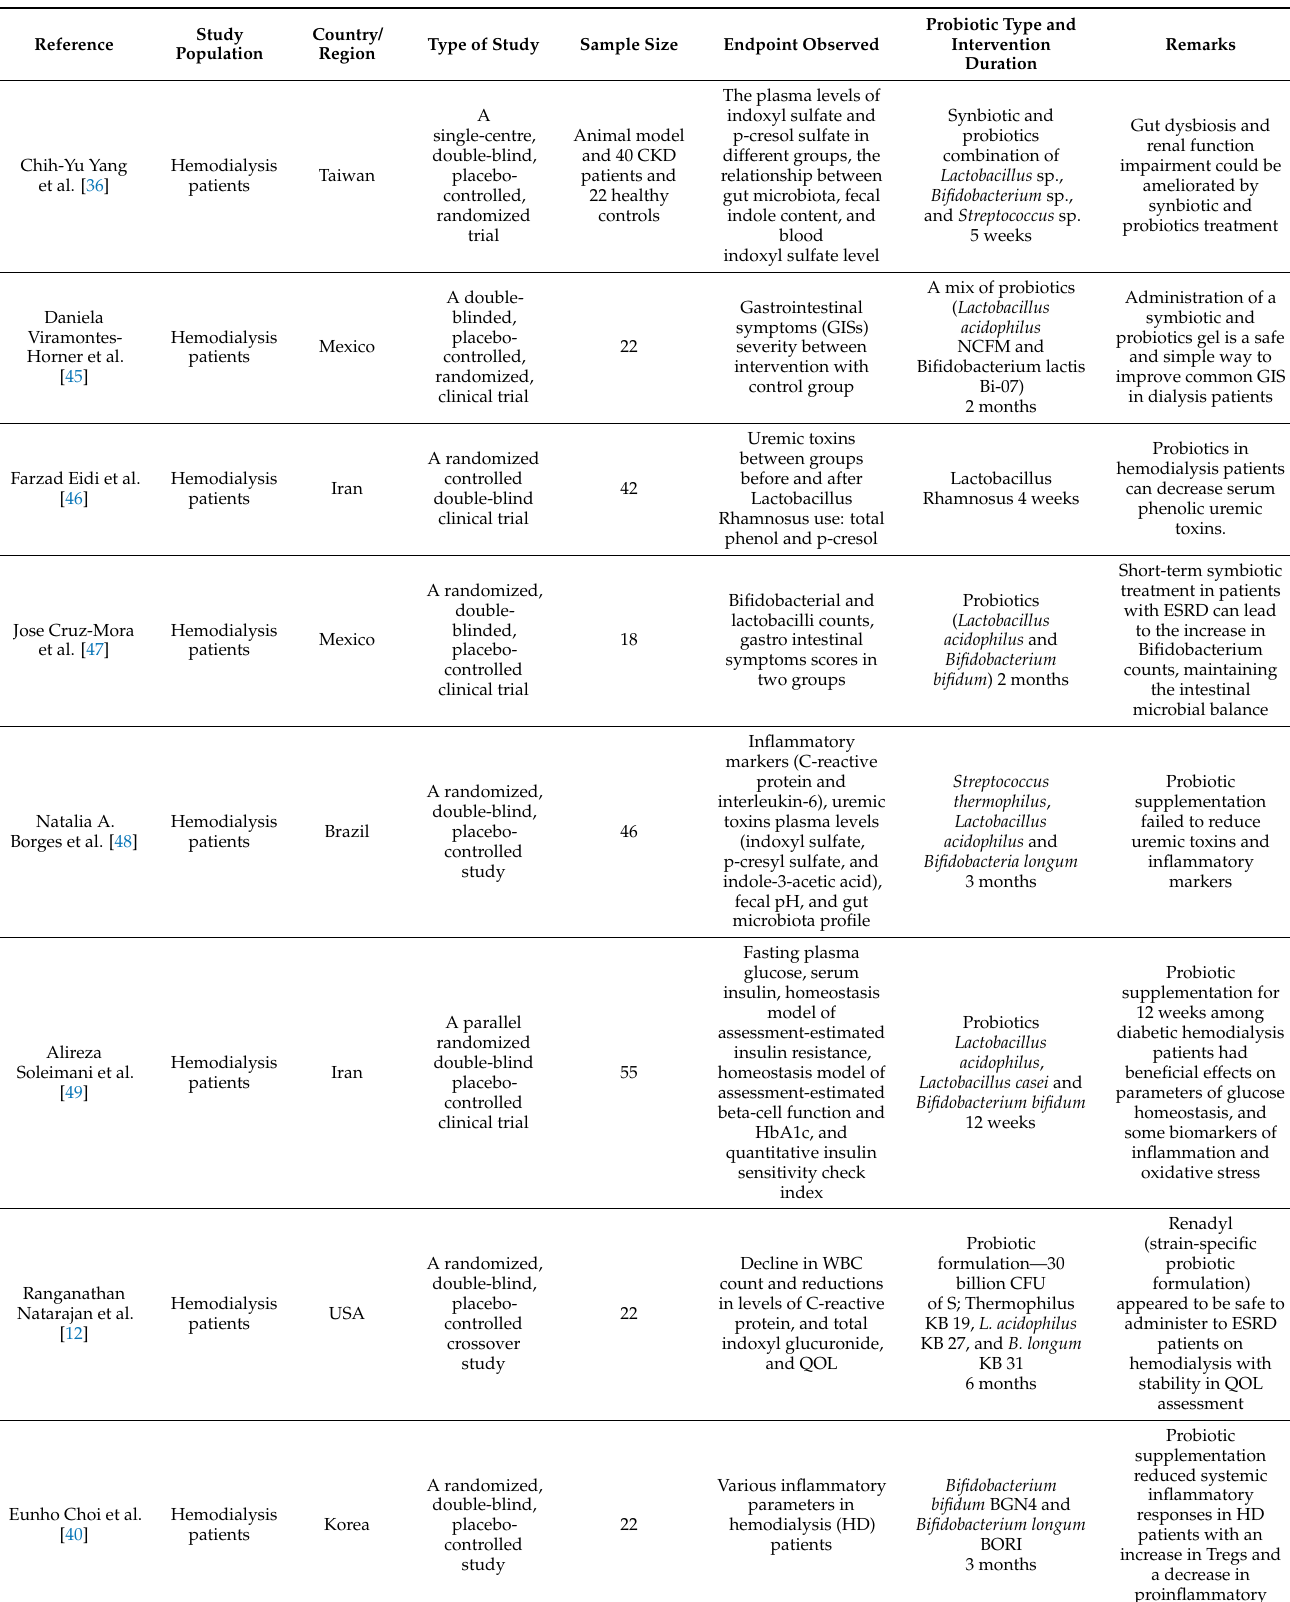
Table 2. Summary of clinical trials on probiotics treatment used in patients with maintenance hemodialysis and peritoneal